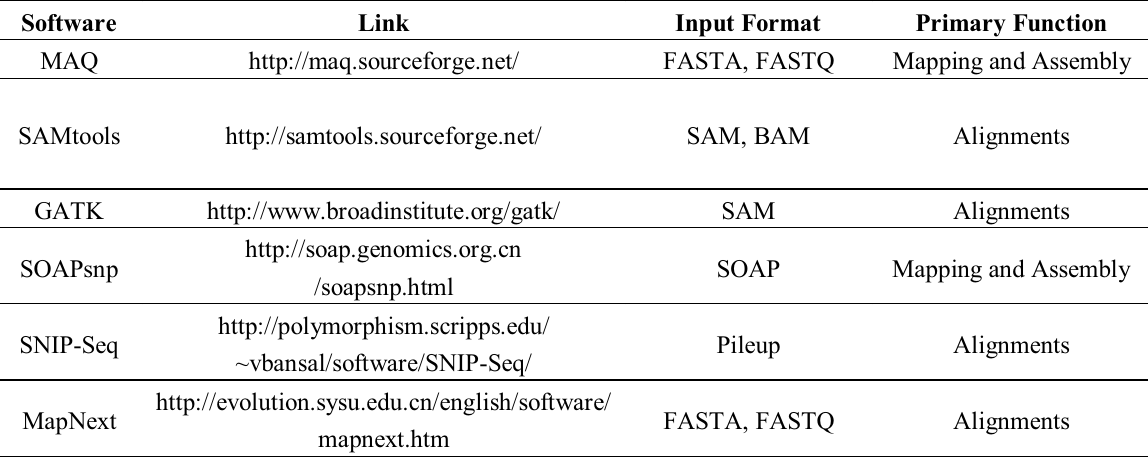
Table 2. Non-exhaustive list of available SNP calling software for NGS